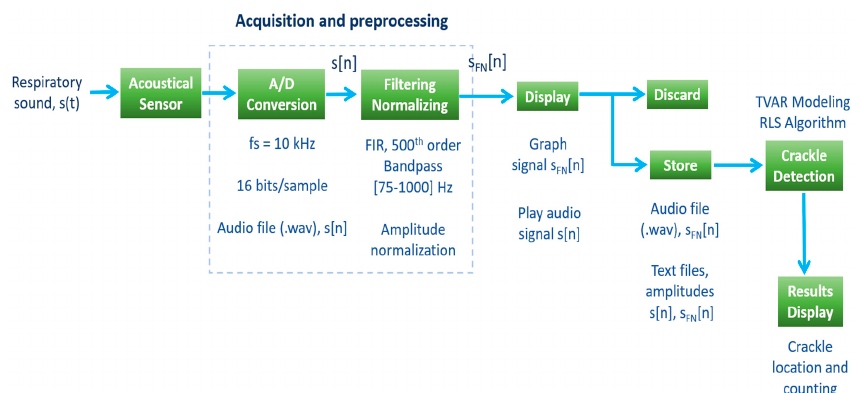
Figure 3. Block diagram of the acquisition, processing and display of results from respiratory sounds with the developed mobile app.